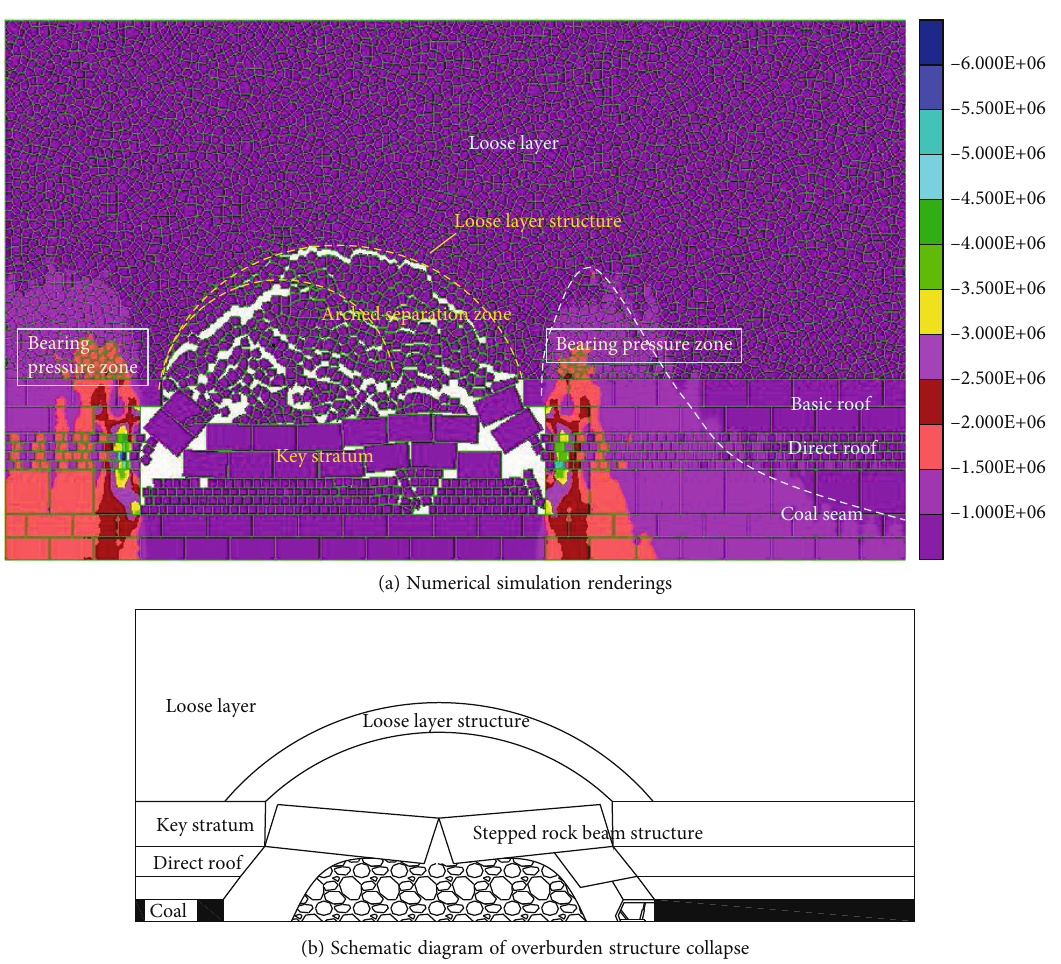
Figure 15: Schematic diagram of arch structure during the fi rst